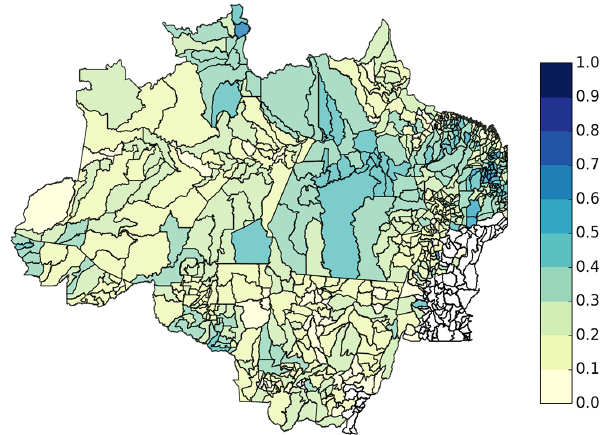
Figure 6. Relative areas that undergo changes in land-use classes between the years 2010 and 2012 (excluding primary